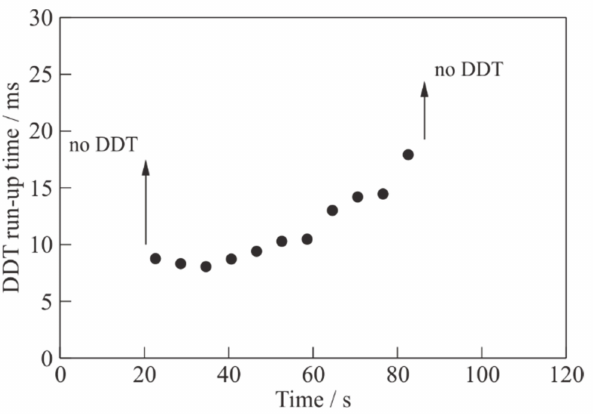
Figure 9. The measured values of the DDT run-up time in detonation shots of the experiment of Figure 6 ( T p = 765 ◦ C and m 0 = 10 g).